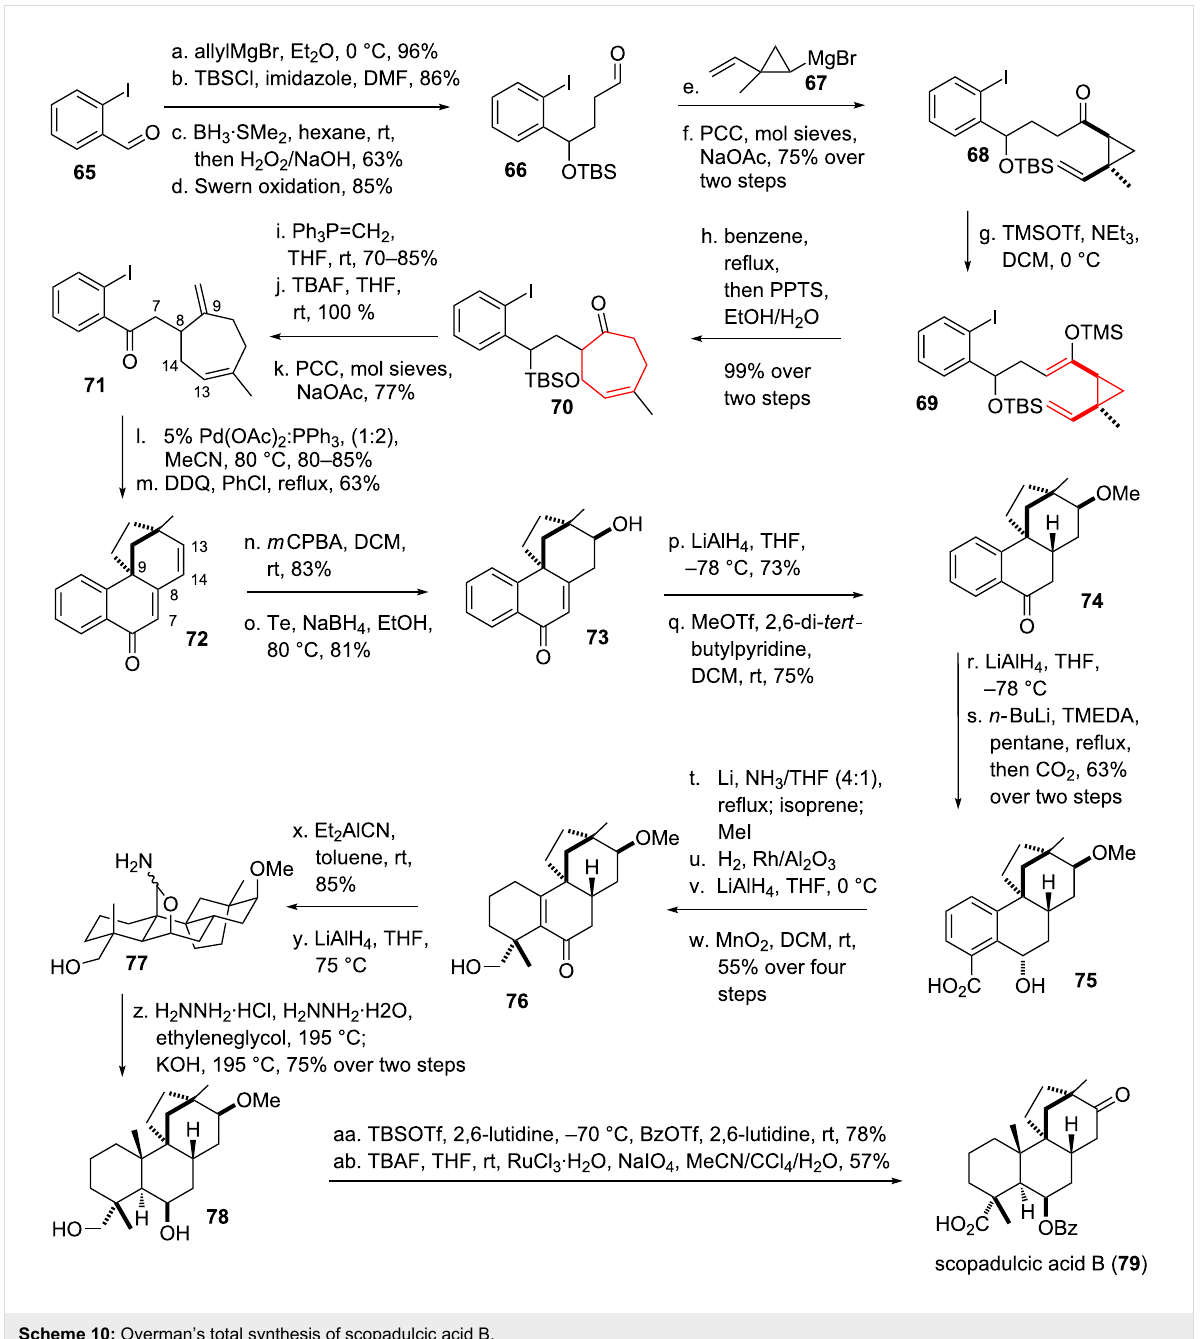
Scheme 10: Overman’s total synthesis of scopadulcic acid B.